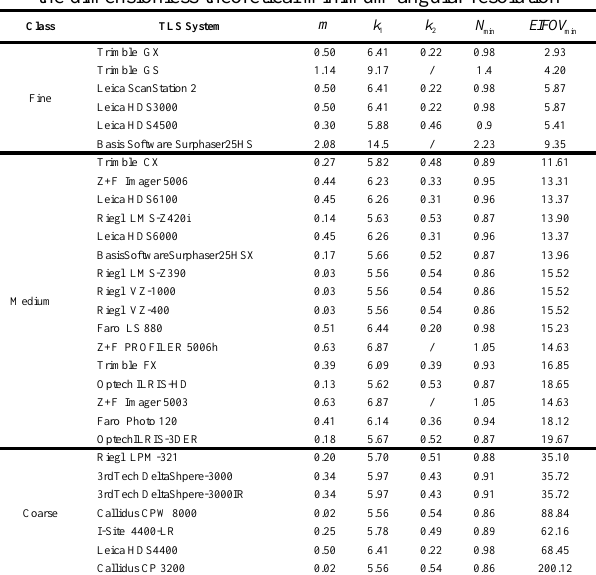
k and k as well as 1 2